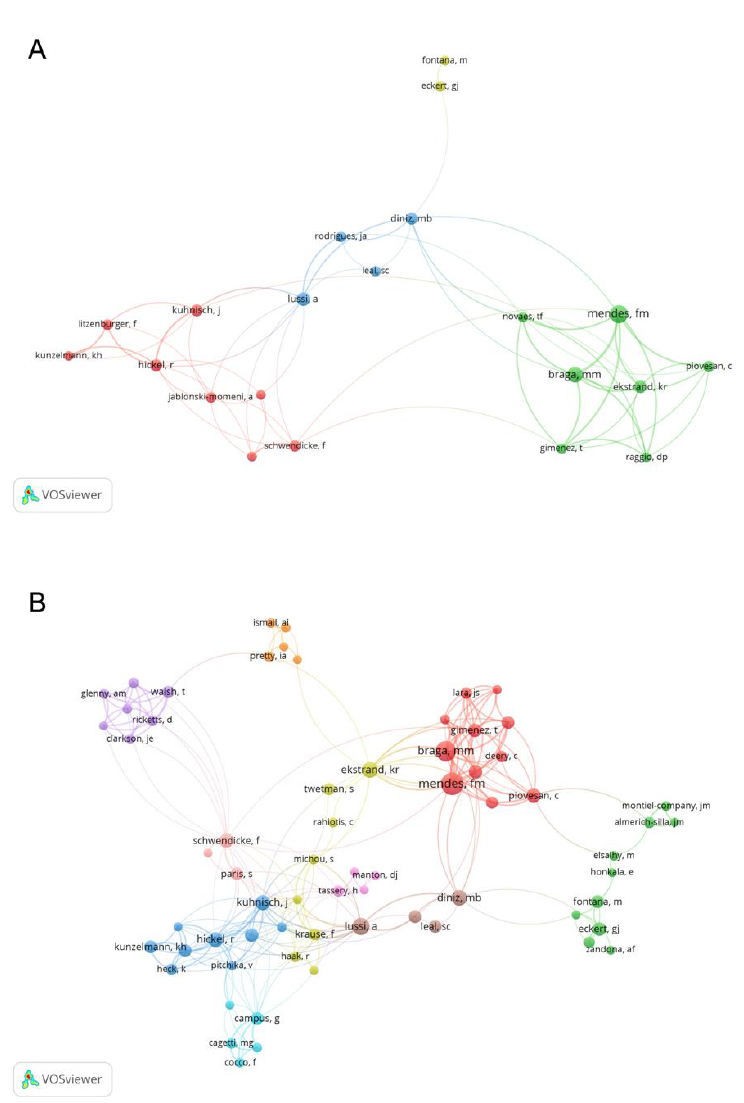
Figure 5. ( A ) Authors with at least ten publications on caries diagnosis and the collaborative relationship between them. ( B ) Authors with at least five publications on caries diagnosis and collaborative relationship between them. Bubble size indicates number of documents. Link length indicates closeness of collaboration.